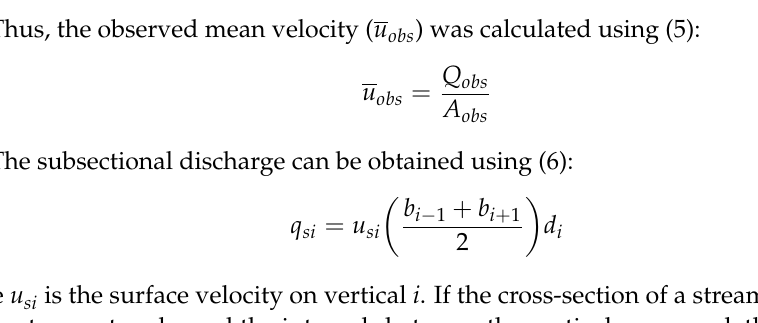
Figure 1. Mid-section method of computing cross-section area and stream discharge.